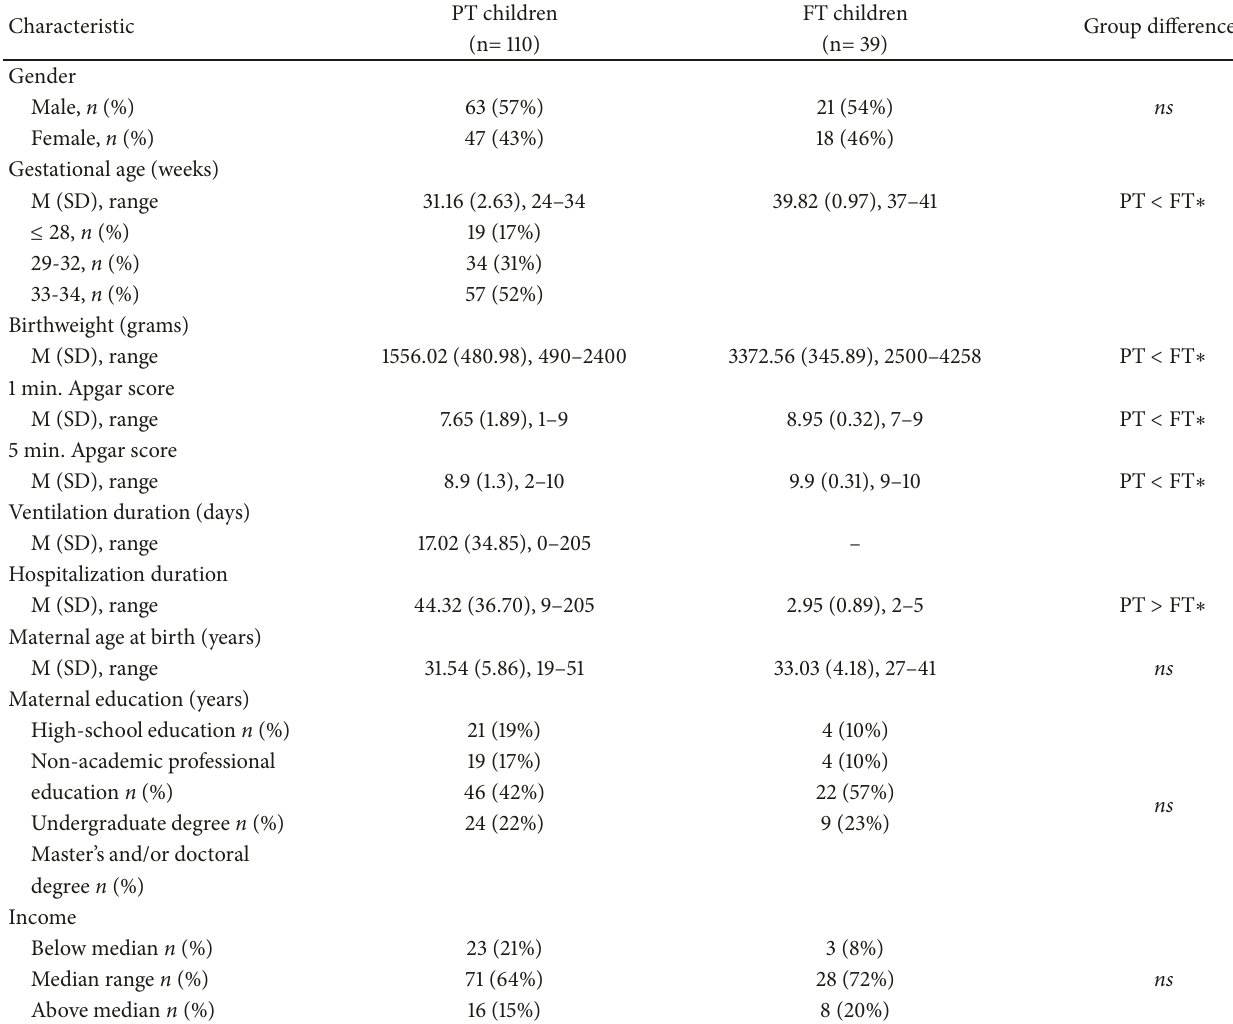
Table 1: Demographic and medical